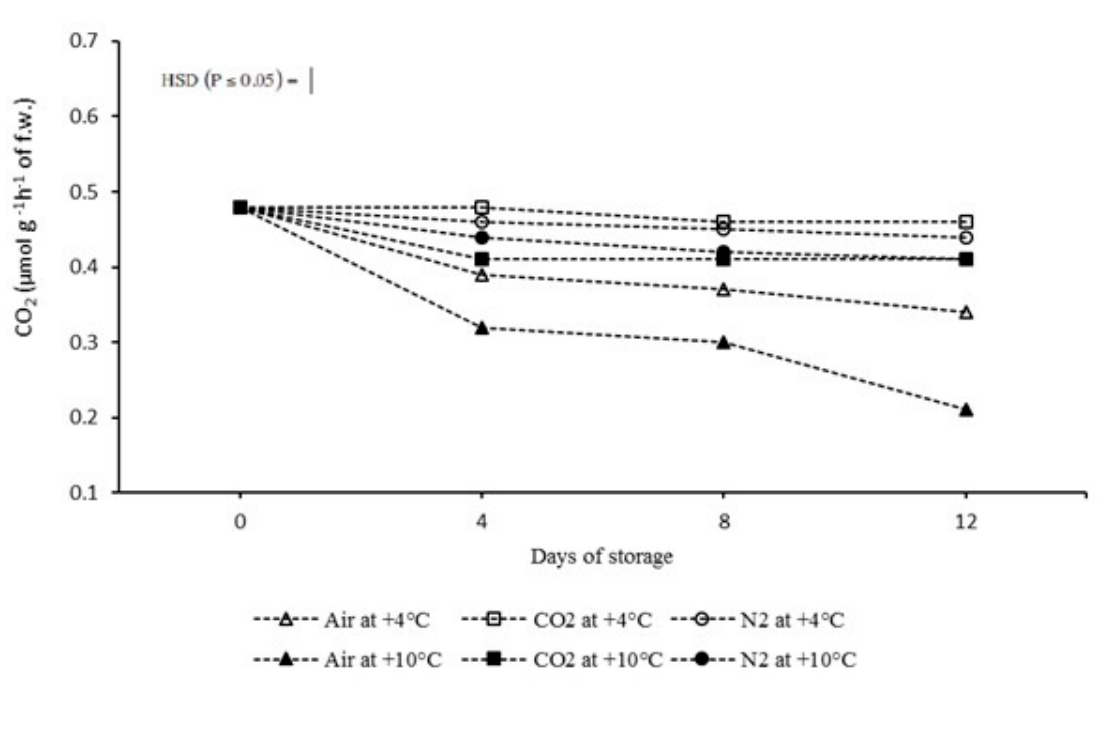
Figure 4. Respiration rate during 12 days of storage at +4 °C and +10 °C in air, 100 ± 1 kPa of CO 2 , and 100 ± 1 kPa of N 2 , respectively.